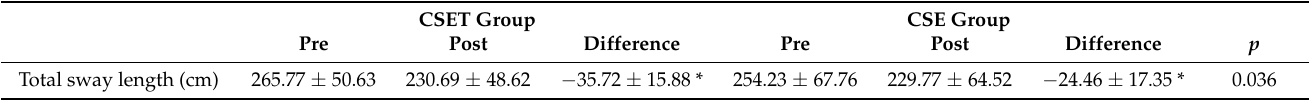
Table 4. Subject scores of balance before and after intervention. CSET